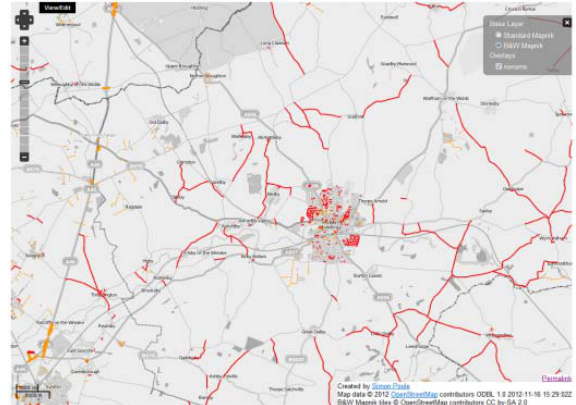
Figure 7: An enlarged section from Figure 6, from the Melton Mowbray area of the UK, shows the true situation